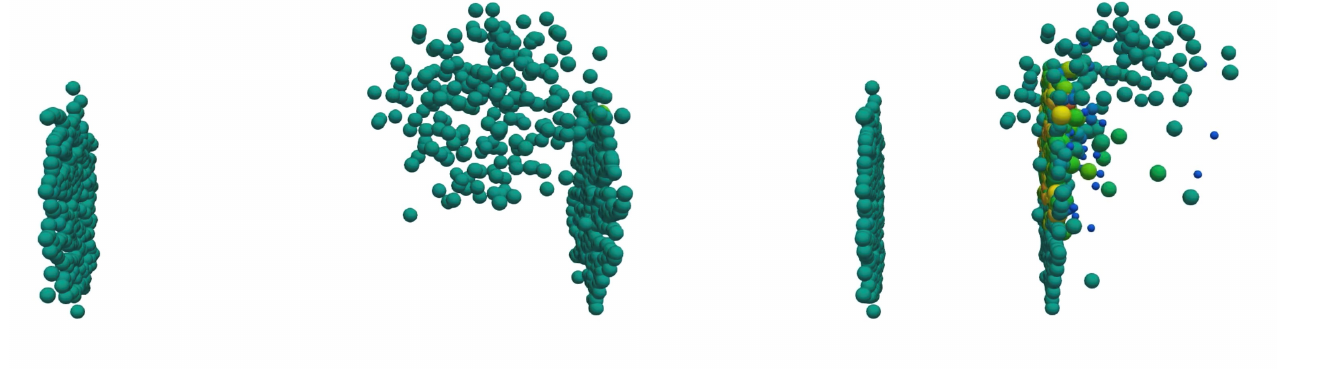
Figure 2. Schematic picture of the non-central Pb+Pb+Pb TNC with time delay t del = 10 fm at the √ s = 2.76 TeV. It visualizes the results of the UrQMD center-of-mass collision energy of beam ions 3.4 simulations: the beginning of collision of target nucleus with the right ion ( left panel ) and the moment when the right ion almost passed through the target nucleus ( right panel ). The volume V h of particles is proportional to their mass m h for a better